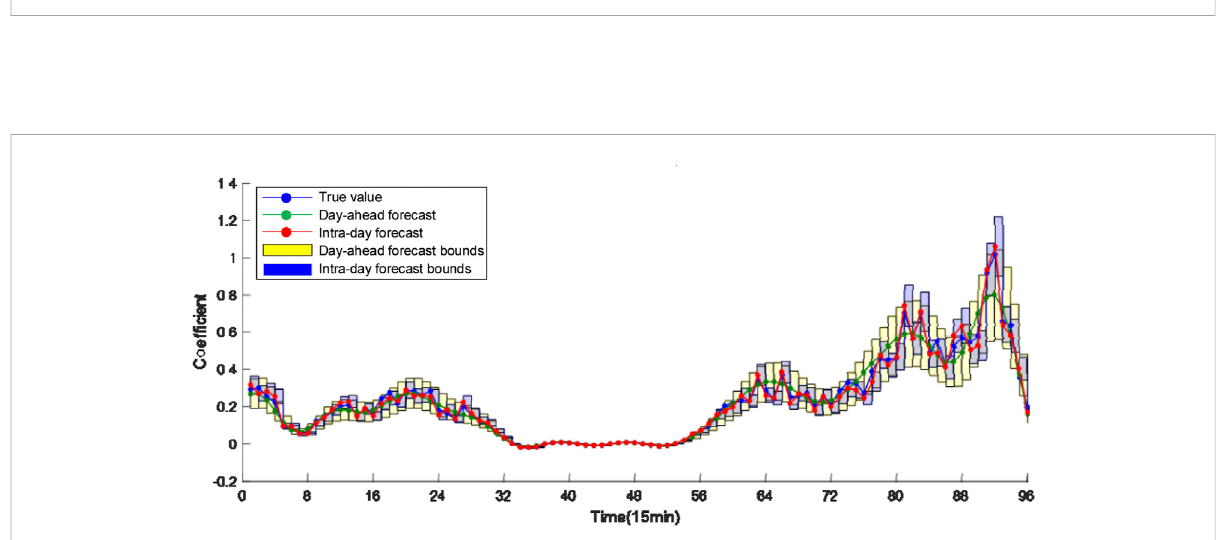
FIGURE 7 Day-ahead and intro-day forecasting curves of wind generation.